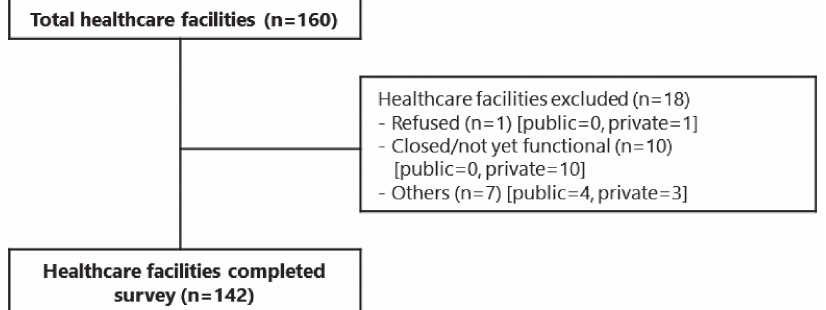
Fig. 1 Flowchart of healthcare facilities selected for the analysis